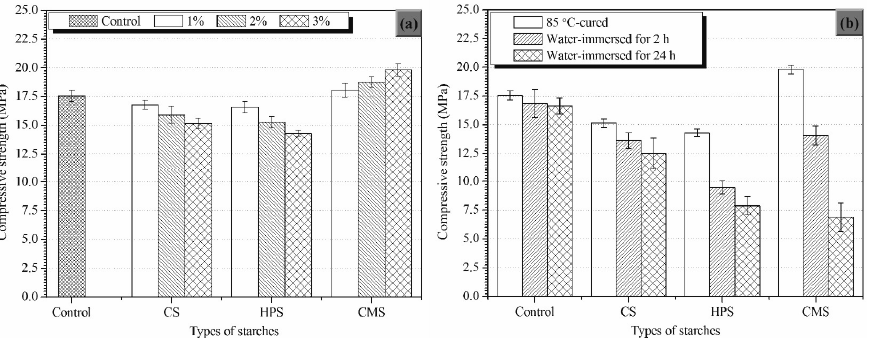
Figure 4. Compressive strengths of: ( a ) 85 °C-cured specimens of control and AAC with different dosages of starches; ( b ) 200 °C-heated specimens after immersed in water for 2 h, 24 h.